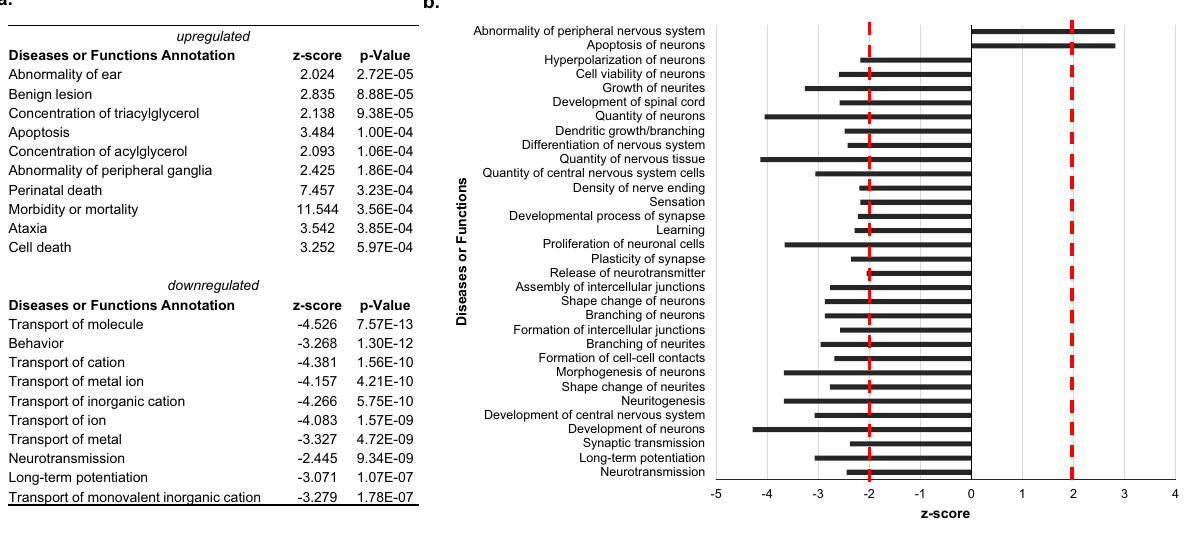
Figure 4. Diseases and functions significantly overrepresented in young versus old mice. ( a ) Top ten diseases and functions significantly enriched among upregulated and downregulated genes in control old versus young male mice. ( b ) Brain-related functions differentially overrepresented in young versus old animals. |z|> 2 is considered significant. Dotted red lines mark z-score = 2.0 or –